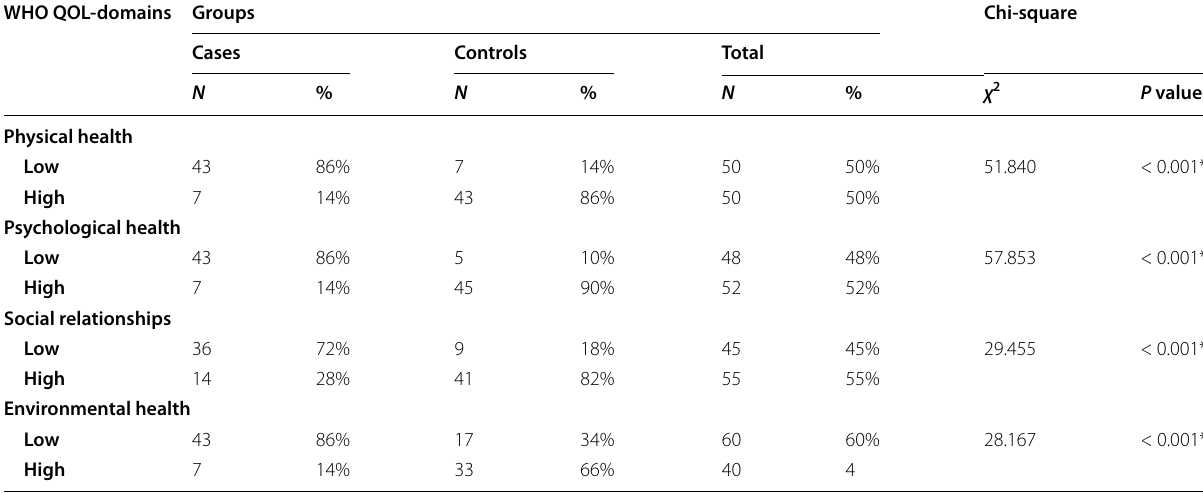
Chi-square test was used *Statistically significant ( P <